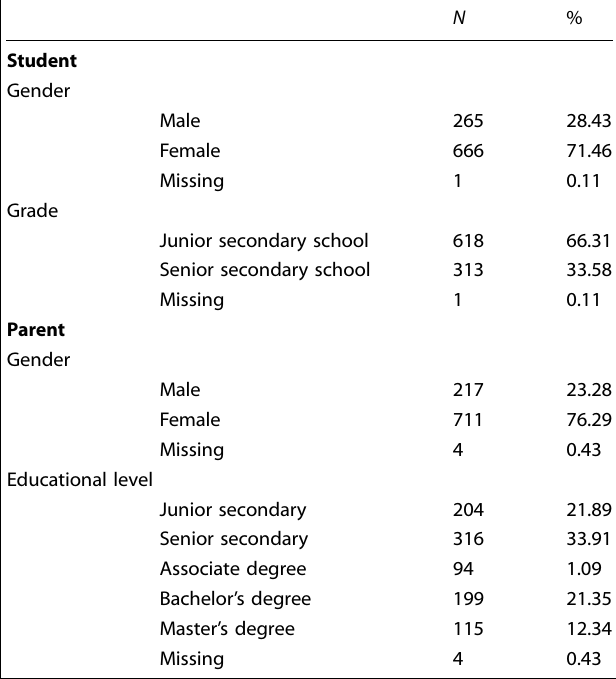
Table 3. Summary of demographic information of